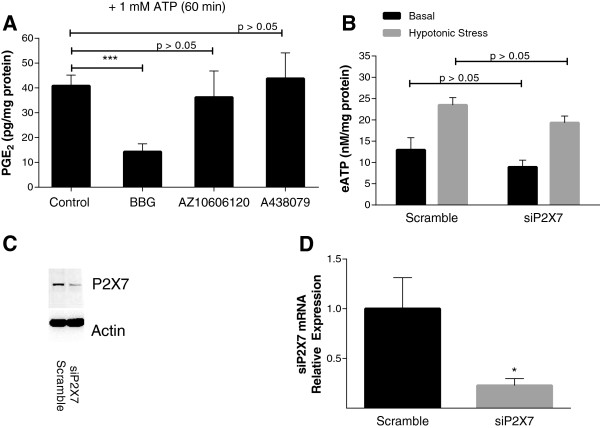
Role of P2X7 receptors in signaling and eATP efflux by chondrocytes. (A) Chondrocytes were treated with no additives (control) or P2X7 inhibitors (Brilliant Blue G (BBG), AZ10606120 or A438079) for 1 h in the presence of 1 mM ATP. Prostaglandin E2 (PGE2) levels in the media were measured using the Parameter™ Prostaglandin E2 kit (R&D Systems). Bars represent mean ± standard error. BBG reduced ATP-induced PGE2 levels (n = 8; ***P <0.001). (B) Chondrocytes were transfected with siRNA for P2X7 or a scrambled control. After 48 h, cells were exposed to hypotonic media for 10 minutes (gray bars) or isotonic media (black bars) and eATP levels were measured. Bars represent mean ± standard error. Under control conditions, a hypotonic challenge consistently increases (eATP). No differences in eATP levels were noted in siP2X7-treated chondrocyte media (n = 8; P >0.05). In parallel cultures at 48 h, protein and mRNA were isolated from scramble or siRNA-treated cells as described and used to assess levels of P2X7 receptor protein (C) and mRNA (D). mRNA levels of P2X7 were suppressed in siRNA-treated cells (*P <0.05). Western blots compare the effects of siRNA effects on P2X7 receptor levels versus actin.